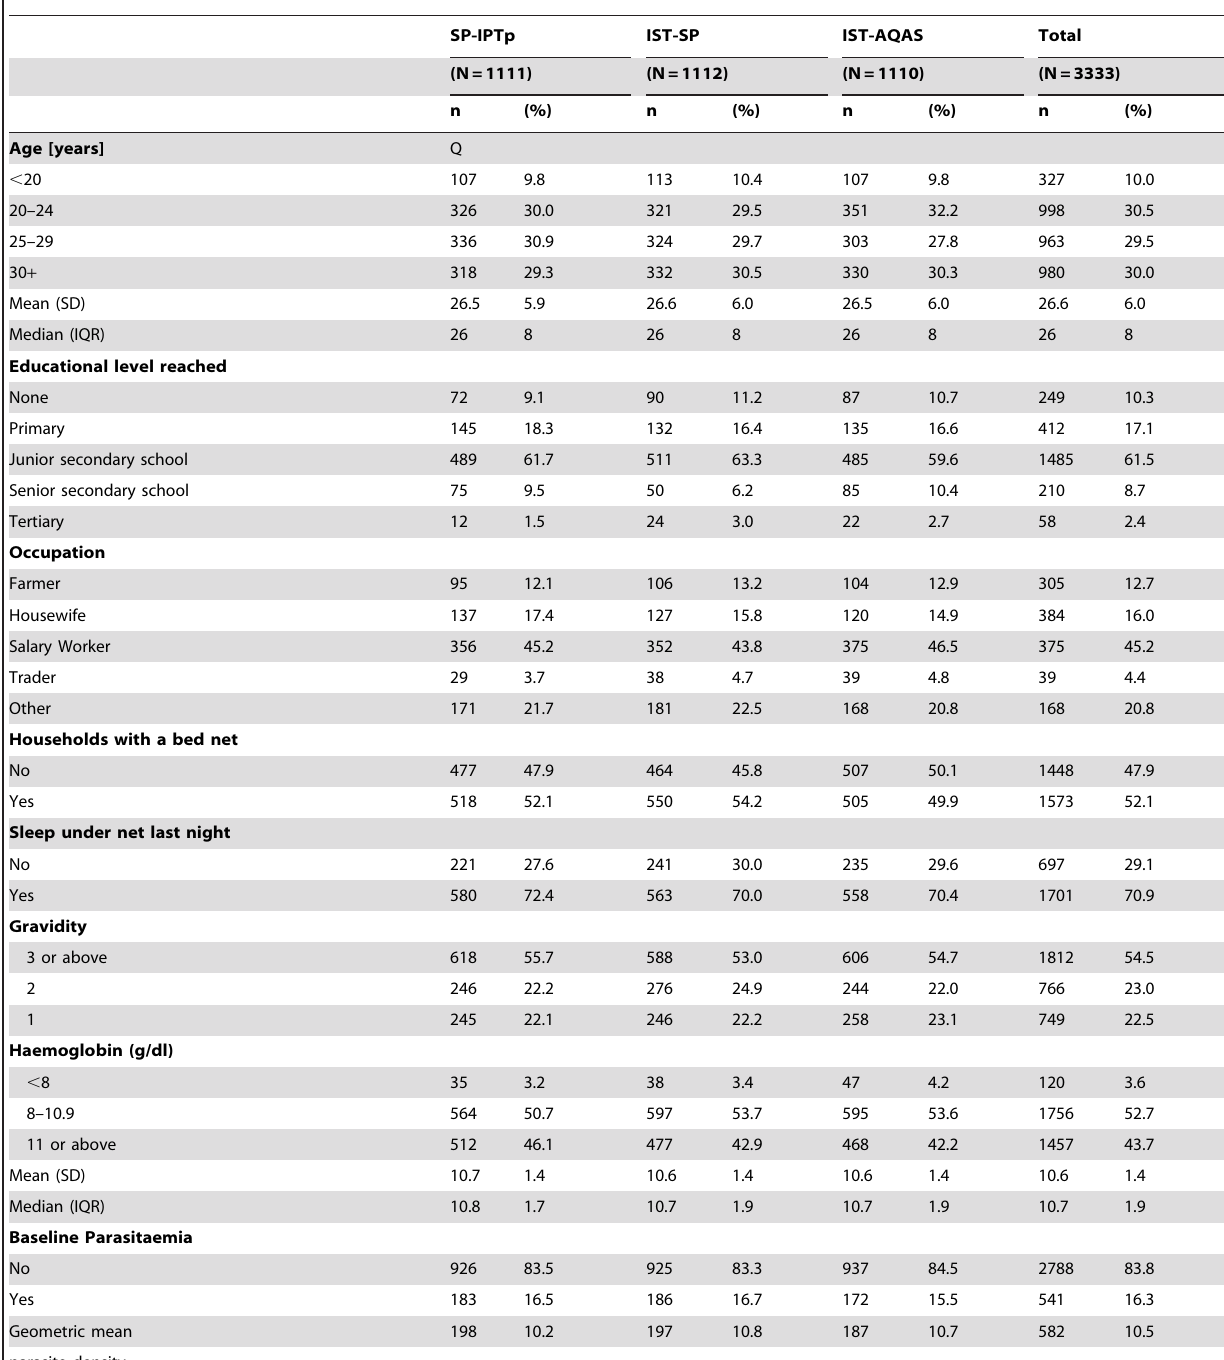
Table 1. Comparison of demographic and baseline characteristics of study